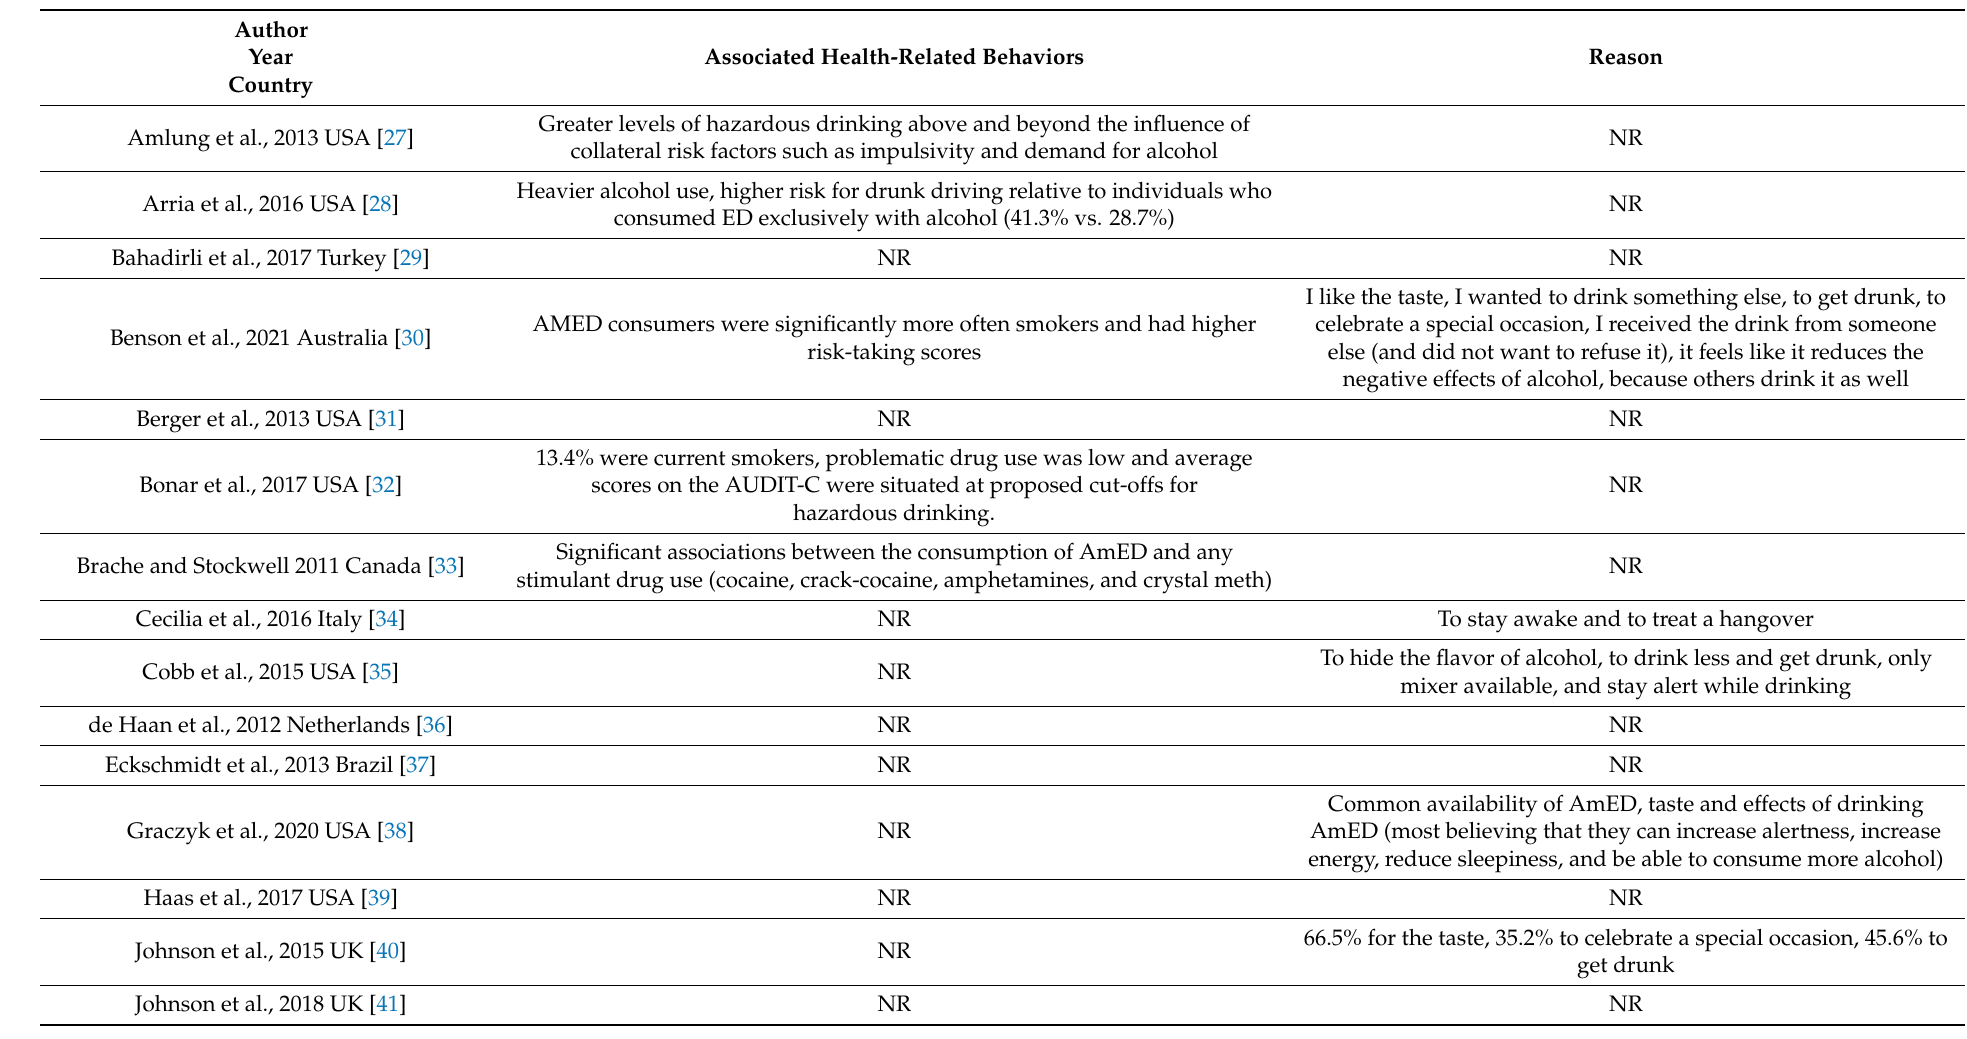
Table 4. Health-related behaviors and motivation associated with Alcohol mixed with Energy Drinks (AmEDs) consumption in the selected